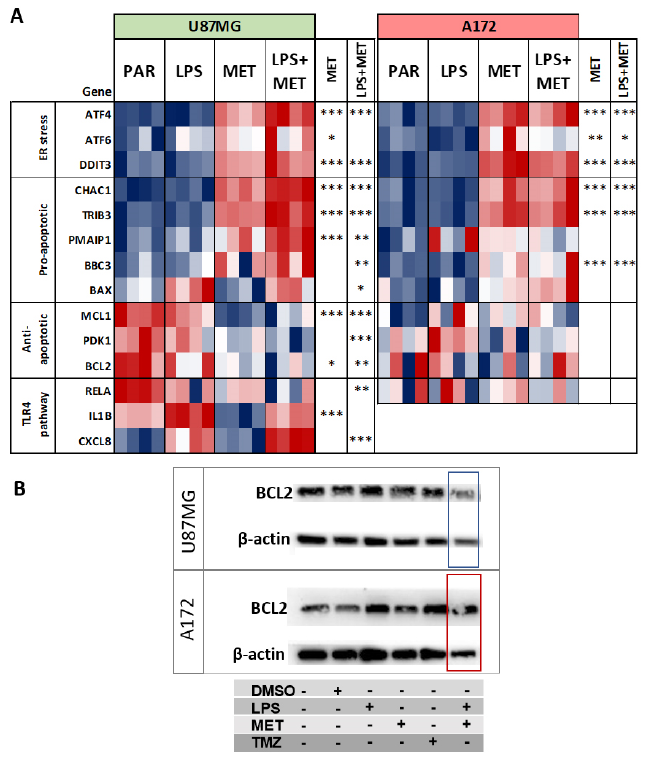
Figure 6. ER stress, pro- and anti-apoptotic and TLR4 pathway related gene expressions. ( A ) Heatmap for expression values of genes related to ER stress, pro − apoptotic, anti − apoptotic and TLR4 pathway in U87MG cells and A172 cells after LPS and MET single and combined treatments, (*) p < 0.05, (**) p < 0.01, and (***) p < 0.001, Limma t − test for LPS+MET combined and MET single treatment compared to non − treated cells; and ( B ) Western blot results for BCL2 of U87MG and A172 parental, DMSO, LPS, TMZ, MET single treated cells. β -actin was used for protein loading control.